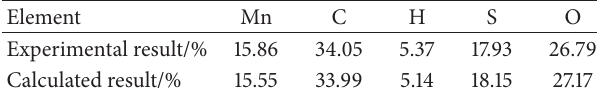
Table 1: Elemental analysis data of the complex Mn(HMHA) 2 .